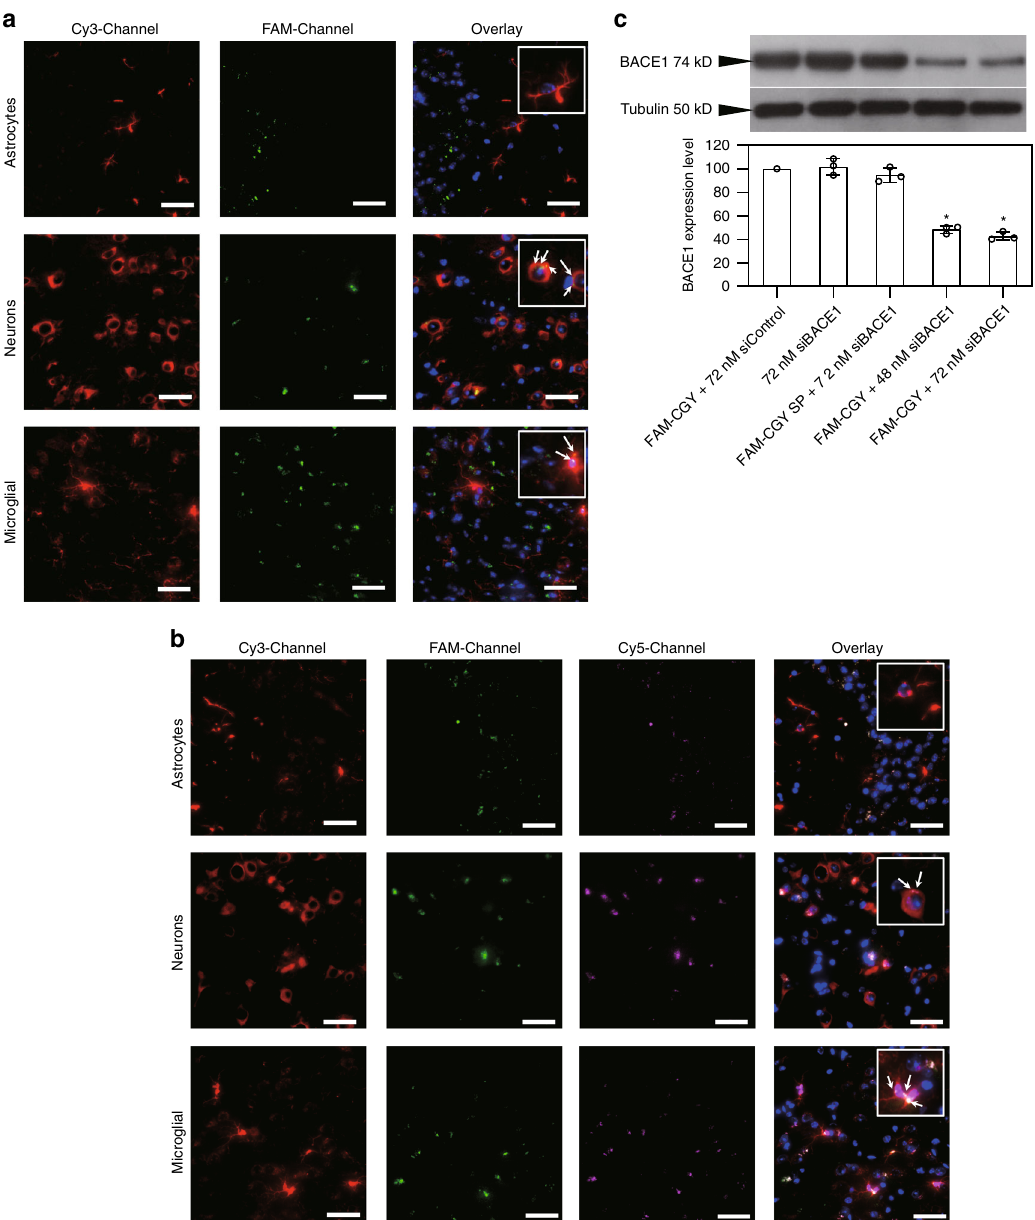
Fig. 5 Brain localization of NLCs and NLC-siRNA complexes and demonstration of pharmacological activity. a , b Fluorescent microscopy images of brain cerebral sections at 4h after the administration of FAM-CGY NLCs ( fi nal concentration of 10 μ M) ( a ) and FAM-CGY/Cy5-siRNA complexes (FAM-CGY = 10 μ M, Cy5-siRNA = 48nM) ( b ), respectively. Astrocytes, neurons and microglia were labelled with anti-GFAP, anti-Tuj1, anti-Iba1 antibodies, respectively and visualised with a secondary fl uorescent antibody (Cy-3 channel). Inserts represent enlarged sections. Arrows indicate FAM-CGY NLC and FAM-CGY/ Cy5-siRNA complexes. Cy3-Channel: astrocytes or neurons or microglial cells; FAM-Channel: FAM-CGY NLCs, Cy5-Channel: Cy5-siRNA. Cell nuclei are stained with DAPI. Scale bar = 40 μ m. The images show NLC localization to neurons and microglial cells, but not astrocytes. c Western blot demonstration of suppression of β -secretase 1 (BACE1) expression in hippocampus following a single intravenous injection of FAM-CGY/BACE1 siRNA complexes. Silencing was compared with FAM-CGY/siControl injection. BACE1-speci fi c siRNA alone or delivered with the FAM-CGY scrambled peptide 1 (FAM-CGY SP) did not induce silencing. BACE1 expression was measured 48h after administration. The results represent mean values of three separate experiments± s.d. * p <0.05, non-paired two-sided student t -test compared with respective siControl (control siRNA). Source data are available in the Source Data fi